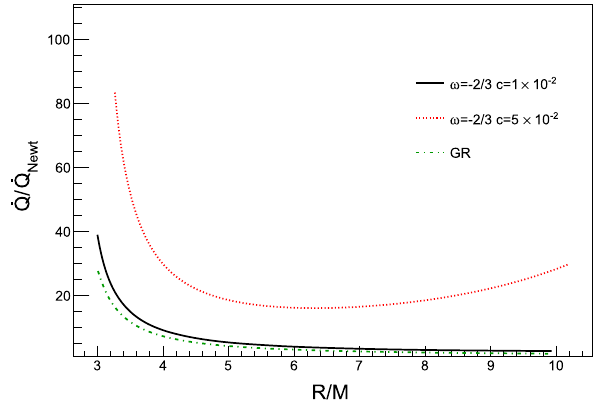
Fig. 3 Ratio of total energy deposition ˙ Q for ω = − 2 / 3 to total New- tonian energy deposition ˙ Q Newt for three values of the parameter c . The green curve shows the GR energy deposition for comparison